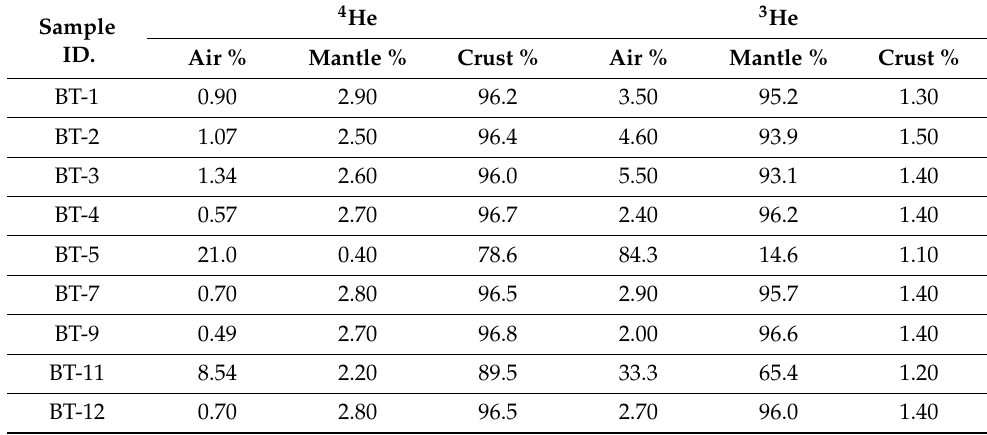
Table 3. Original content ratio of 3 He and 4 He in Bugok thermal waters.